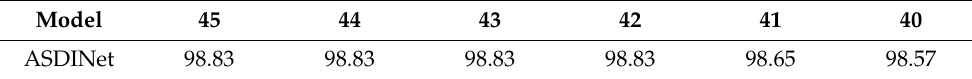
Table 10. The performance of the ASDINet trained between 45-40 defective images.